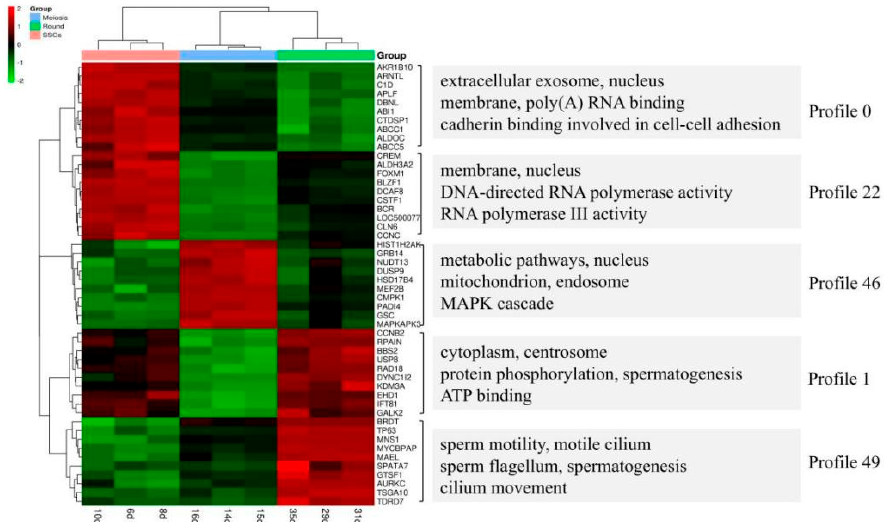
Figure 5. RNA-seq heat map of all three stages of cells with key genes and enriched GO terms at the right.